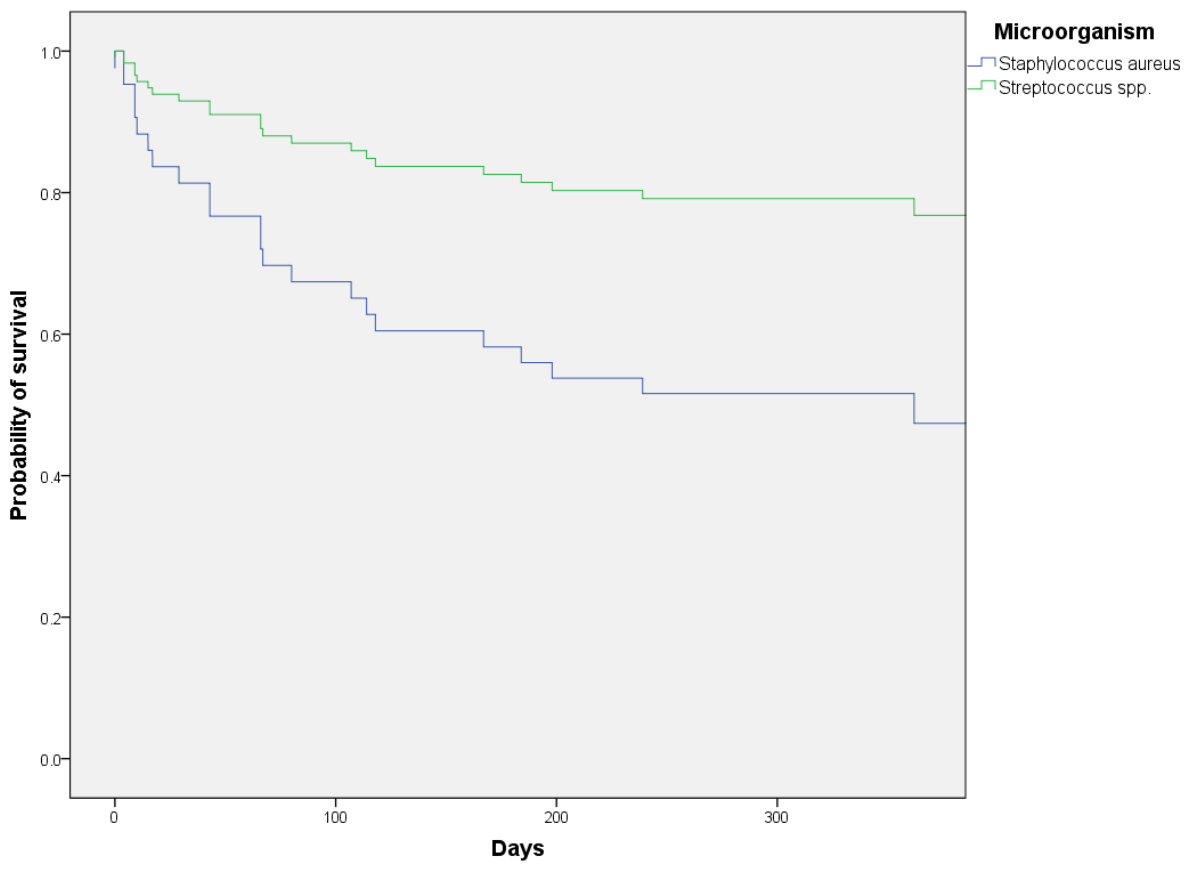
Figure 2. Cox proportional hazard regression showing impaired one-year survival in patients with surgically treated Staphylococcus aureus endocarditis compared to Streptococcus spp.